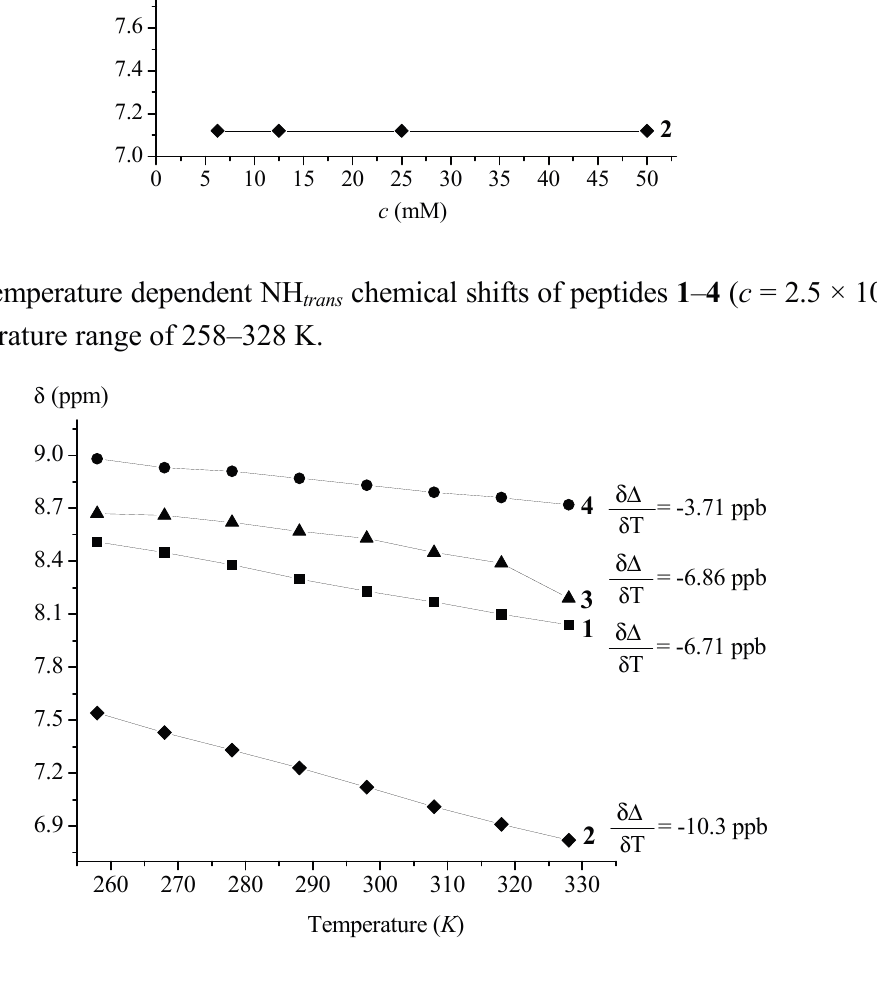
chemical shifts of peptides 1 – 4 ( c = 2.5 × 10 − 2 M) trans